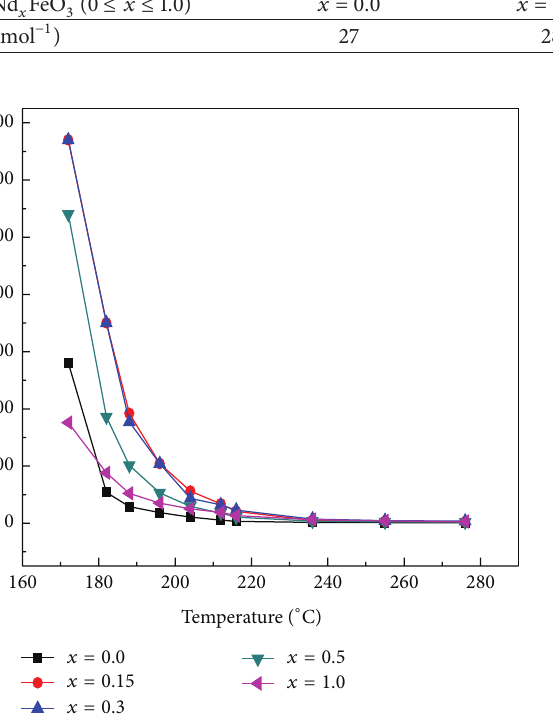
Figure 3: Resistance versus temperature of La 1−𝑥 Nd 𝑥 FeO 3 ( 𝑥 = 0.0 – 1.0 ) measured in air.